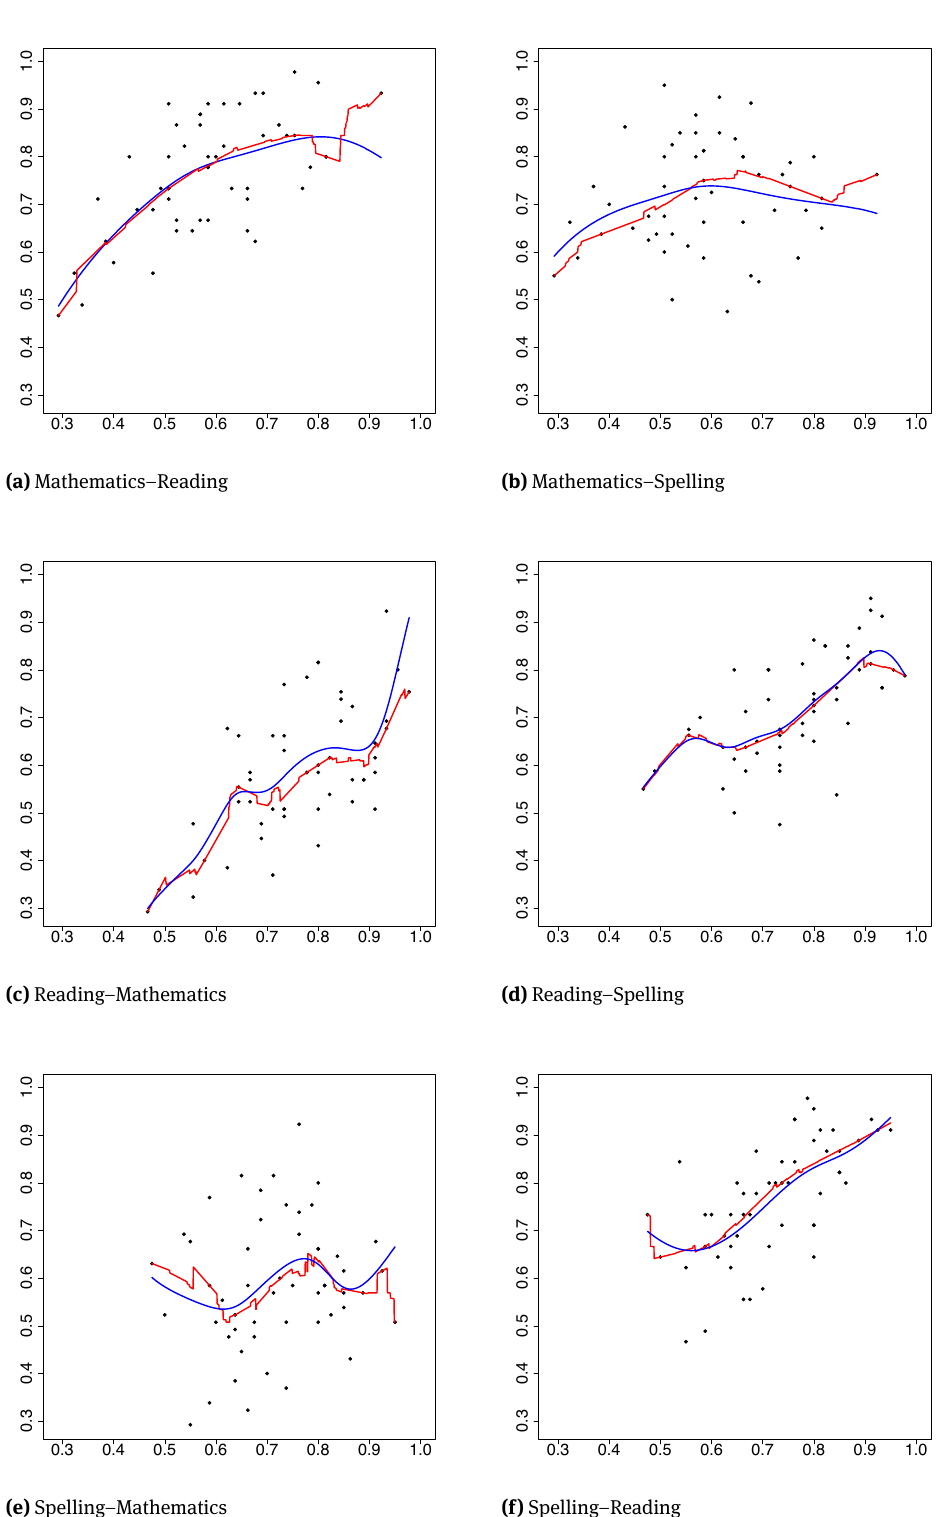
Figure 3: Conditional-mean (blue) and conditional-median (red) based